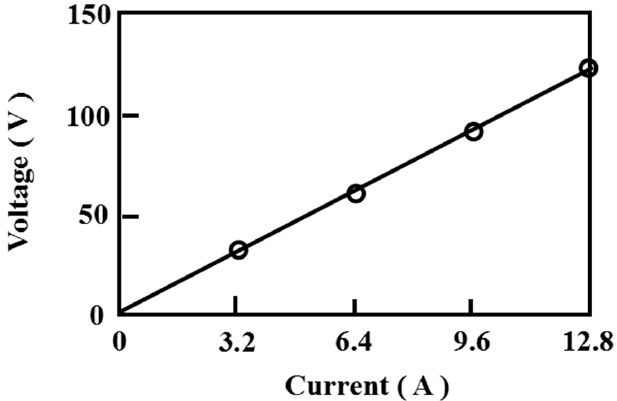
Figure 11. Current–voltage curve.